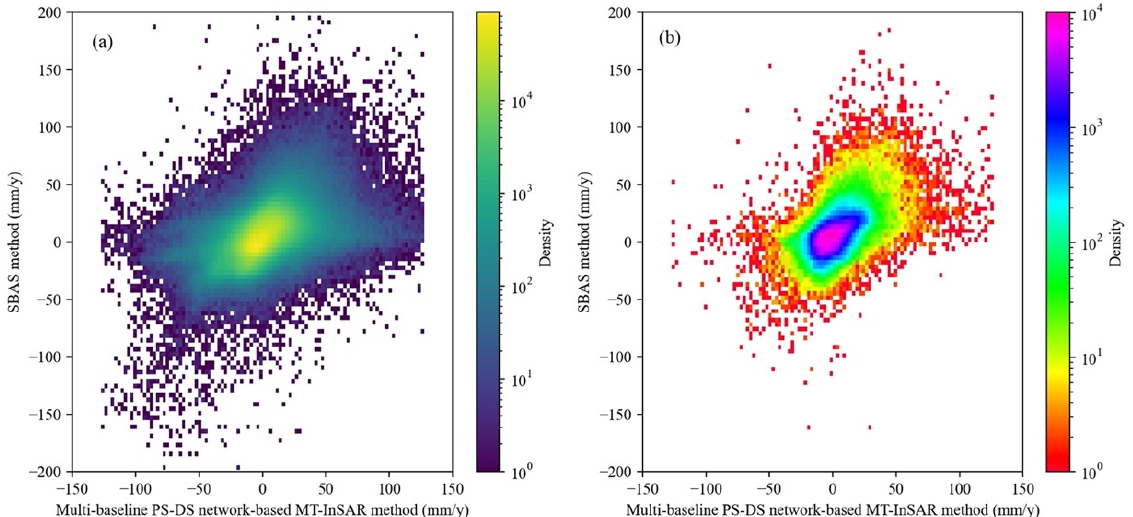
Figure 17. Density scatter plots between the multi-baseline PS–DS network-based MT-InSAR method and the traditional SBAS method. ( a ) The entire area in Figure 12. ( b ) The distributed rock glaciers in Figure 12.